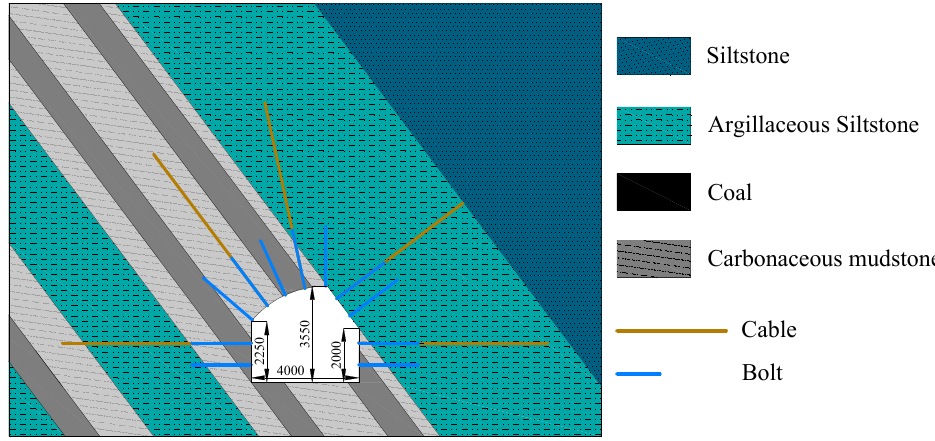
Figure 2. Irregular roadway section and primary support form.